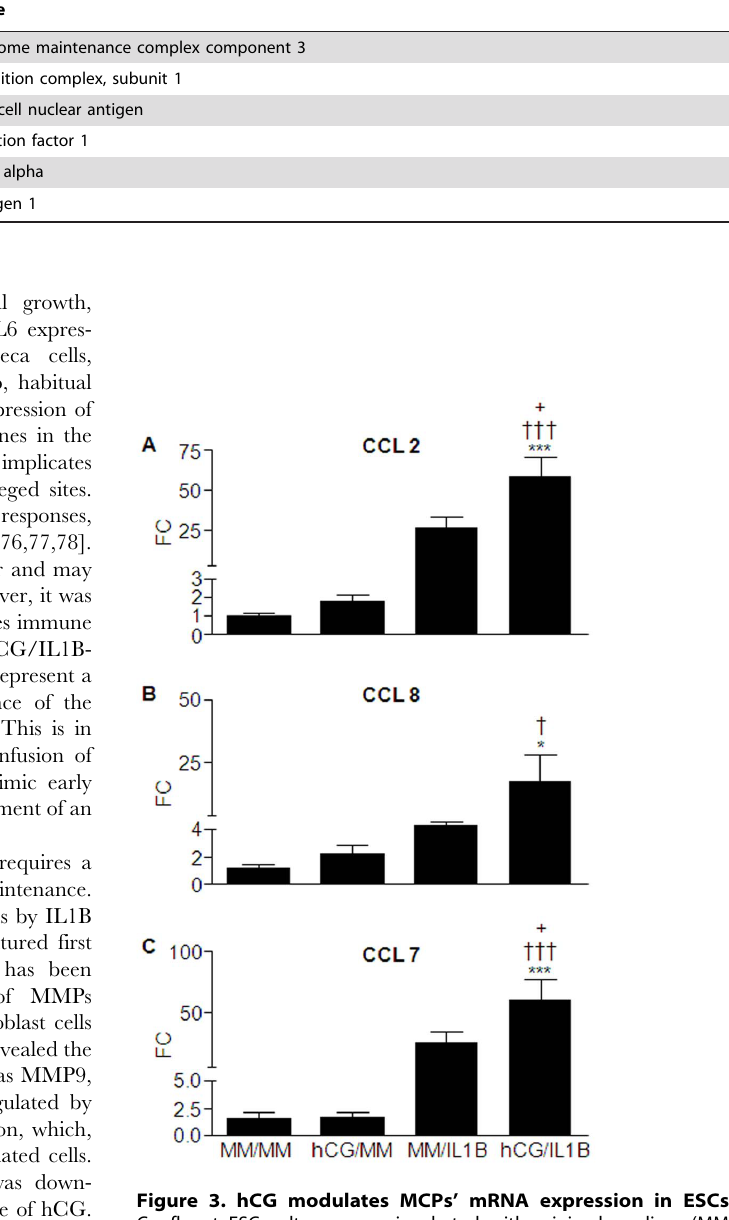
Figure 3. hCG modulates MCPs’ mRNA expression in ESCs. Confluent ESC cultures were incubated with minimal medium (MM) (control) or hCG (100 ng/mL) for 24 h before being exposed or not to IL1B (0.1 ng/mL) for additional 24 h. Total RNA was extracted and reverse transcribed. CCL2, CCL8, CCL7 and GAPDH (internal control) mRNA levels were quantified by real-time PCR. CCL2 (A), CCL8 (B) and CCL7 (C) mRNA ratio was then determined following normalization to GAPDH mRNA. Data were from ESC cultures issued from 7 different subjects and expressed as fold change (FC) over control (ratio of CCL2, CCL8 or CCL7 mRNA levels found in cells incubated with IL1B, hCG or hCG/ILB to those found in cells incubated with MM for an equivalent period of time). *P , 0.05, *** P , 0.001 relative to MM; { P , 0.05, {{{ P , 0.001 relative to cells stimulated with an equivalent concentra- tion of hCG; + P , 0.05 relative to cells stimulated with an equivalent concentration of IL1B. Data were obtained with ESC cultures issued from 7 different subjects (the 3 cultures used for microarray analysis and 4 additional cultures).